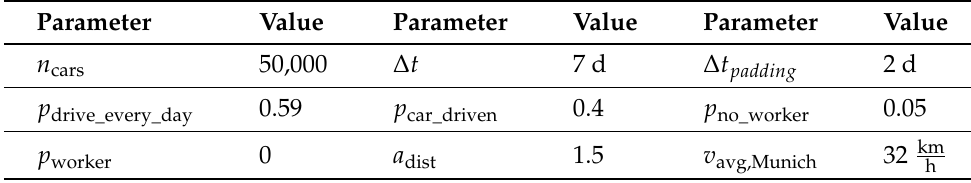
Table 1. Simulation parameters.